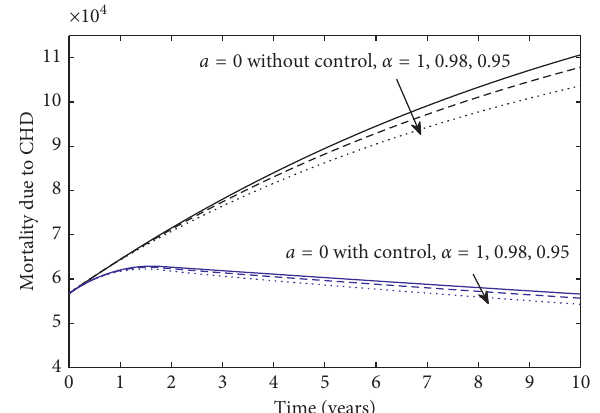
Figure 3: Mortality due to CHD, where a � 0 without control (black lines) and with control (blue lines) for α � 1 (solid line), α � 0 . 98 (dashed line), and α � 0 . 95 (dotted line).